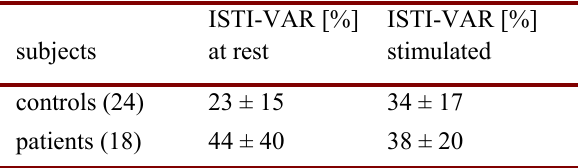
Table 4. Variability in ISTI (ISTI-VAR) ± S.D. [%] in the group of patients with Parkinson’s disease and in the group of control subjects while breathing at rest and during stimulated, deep breathing at 0.1 Hz.